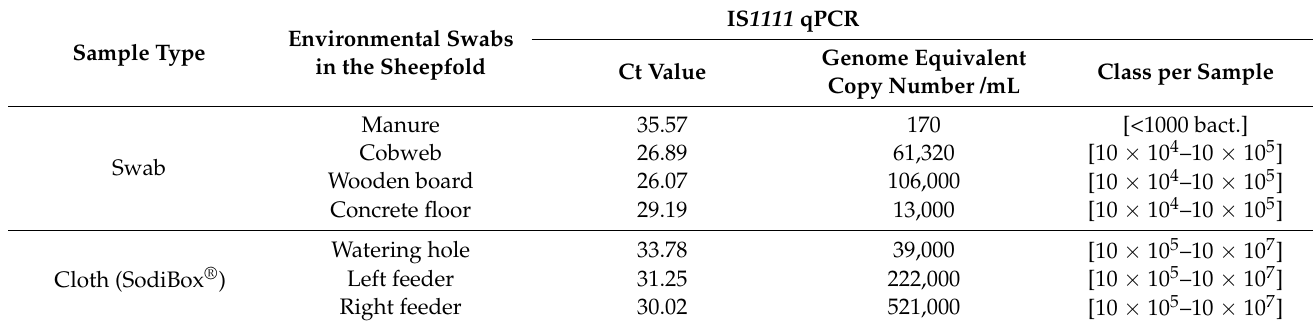
Table 4. Result of real-time quantitative PCR testing on environmental samples.